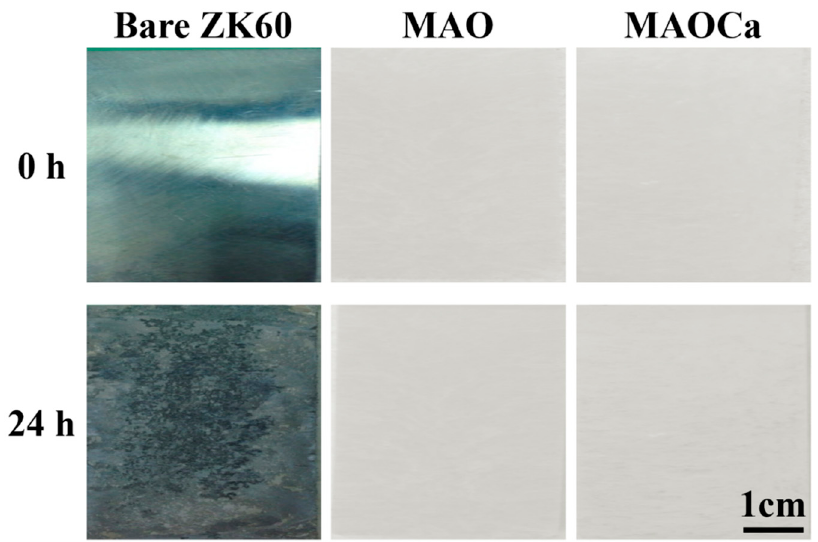
Figure 6. Visual images of the bare ZK60 and samples coated in the MAO and MAOCa treatments after 24 h of the SST.